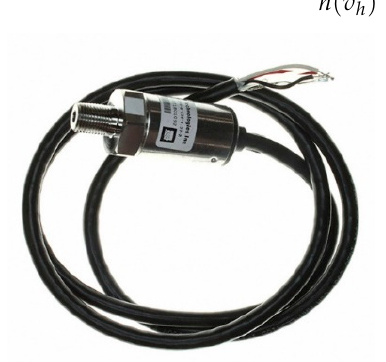
Figure 5. Pressure sensor.